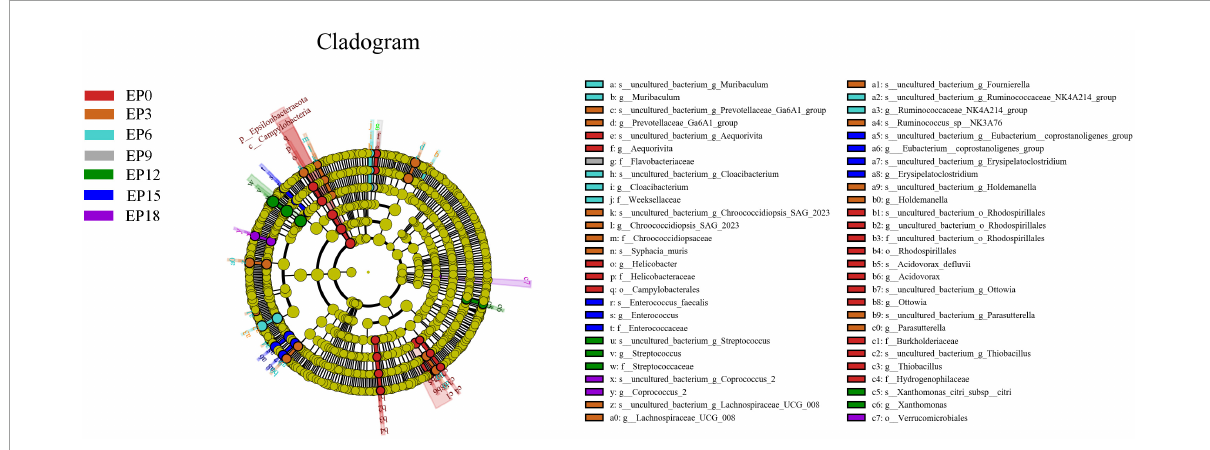
FIGURE7 LEfSe analysis of the intestinal bacteria microbiota in hybrid groupers fed with diets. The circles radiating from the inside to the outside of the evolutionary branch diagram represent the classification levels of phylum (p), class (c), order (o), family (f), genus (g), and species (s).